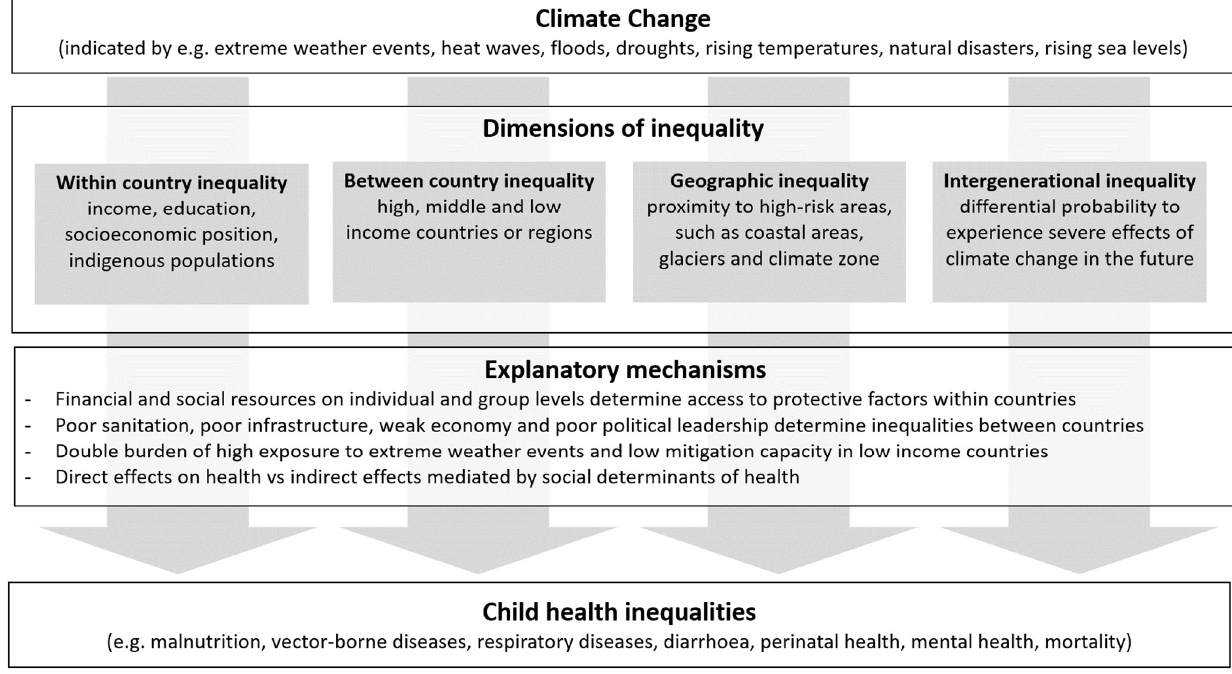
Figure 2. Relationship between climate change and child health inequalities. While inequalities in child health within and/or between countries or geographical regions are touched upon in all the included reviews, few reviews have inequalities as their primary focus. We found descriptive evidence of the differential impact of climate change on children in social groups by relative advantage versus disadvantage within countries and in LMICs compared with HICs; however, quantitative evidence comparing advantaged and disadvantaged children was